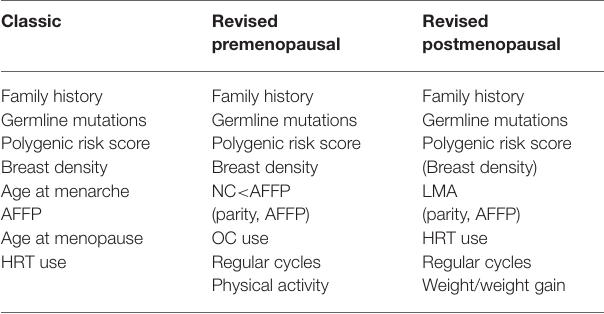
TABLE 2 | Revised risk factor models for breast cancer taking the menstrual cycle into